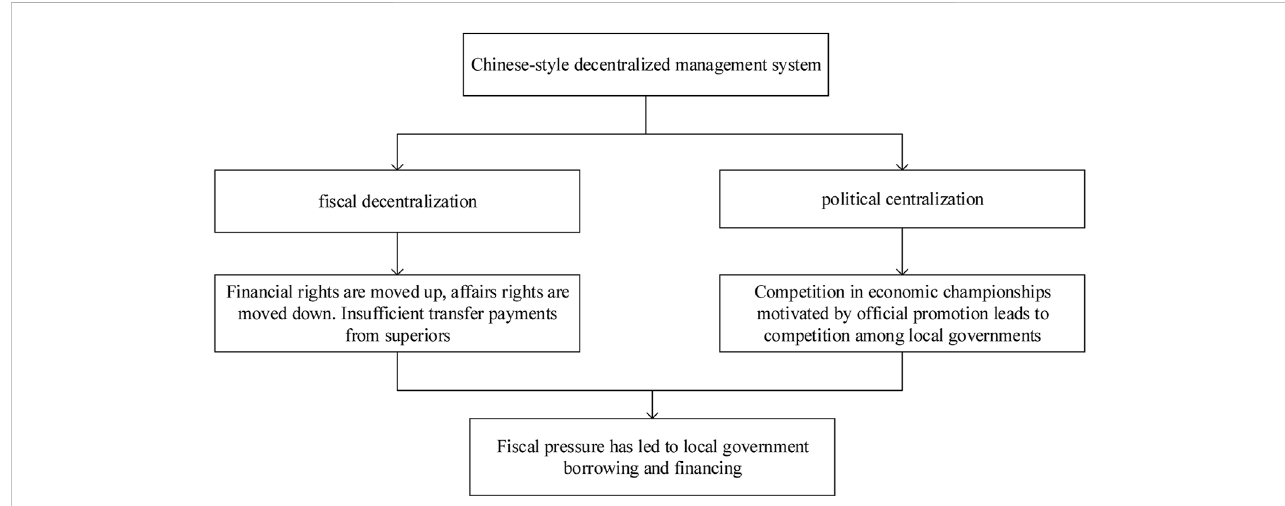
FIGURE 1 The mechanism of the role of fi scal decentralization on local government debt risk.